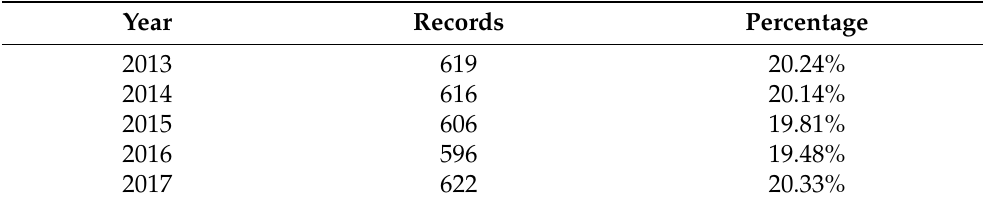
Table 1. Sensor network deployment distribution by